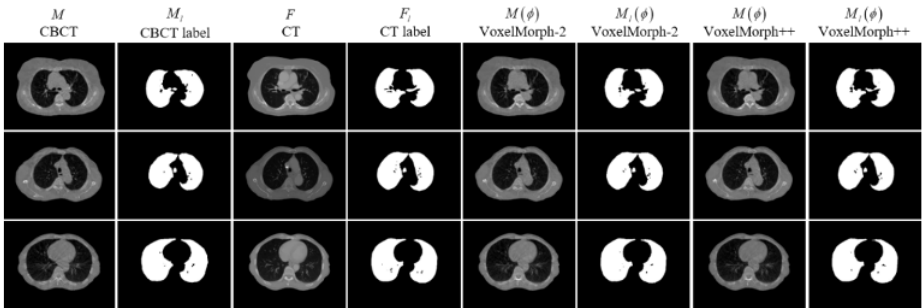
Fig. 3. Example CBCT-CT transverse slices extracted from input pairs (columns 1, 3), corresponding lung region labels made by ITK-SNAP (columns 2, 4), and resulting VoxelMorph-2 and VoxelMorph++ (the proposed architecture). Each line represents a different